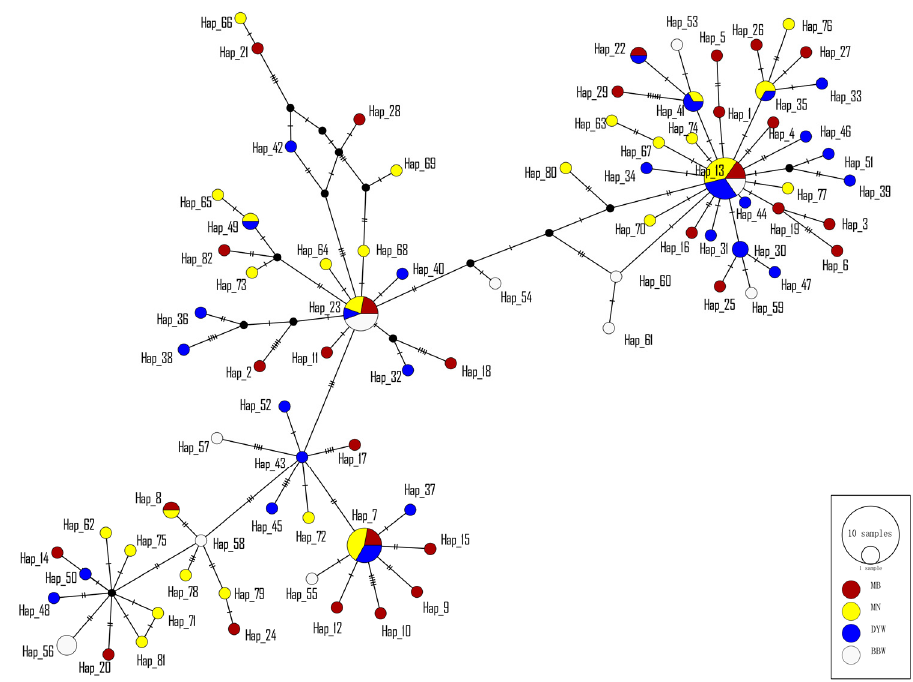
Figure 3. The haplotype network using the TCS algorithm inferred from mitochondrial COI, Cyt b and ND2 genes of Epinephelus awoara from four geographic samples in mainland China. Each circle indicated each haplotype, and the size of each circle is related to its haplotype distribution frequency. Each color in haplotype network circles represents each sampling location.